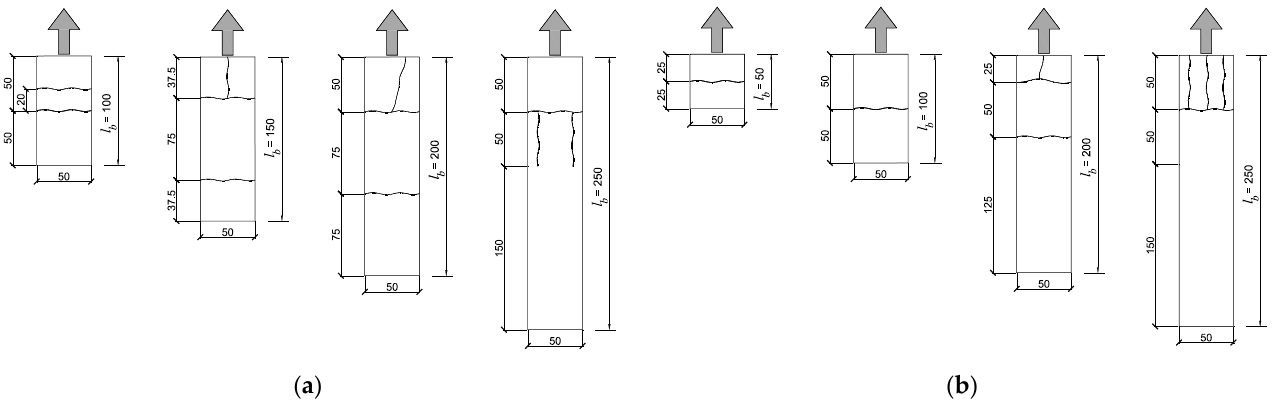
Figure 5. Crack patterns at failure: ( a ) Cementitious-matrix specimens; ( b ) Geopolymeric-matrix